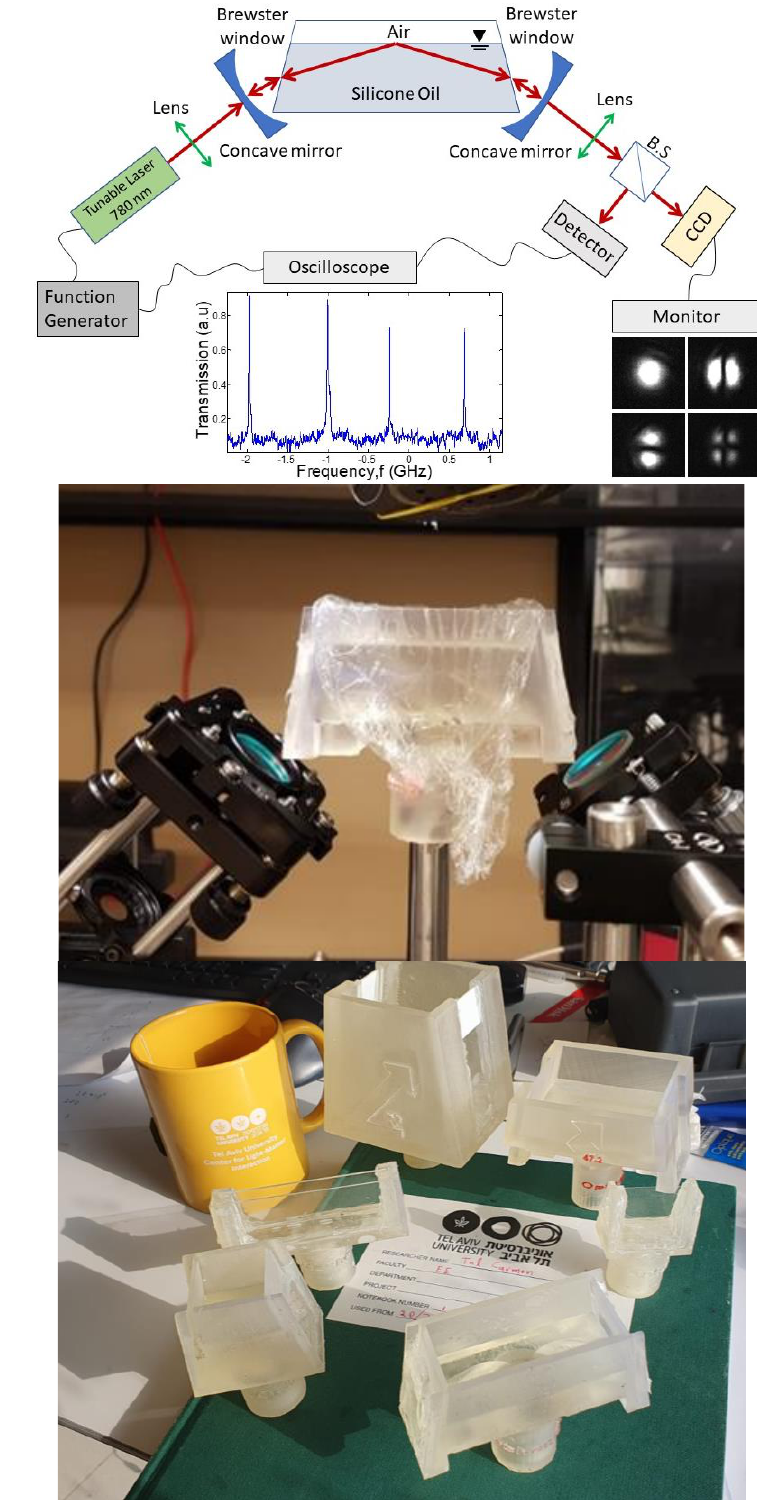
Figure 3. Experimental setup . ( a ) Detailed description; ( b ) the liquid container and the concave mirrors. ( c ) Several models of the liquid containers.